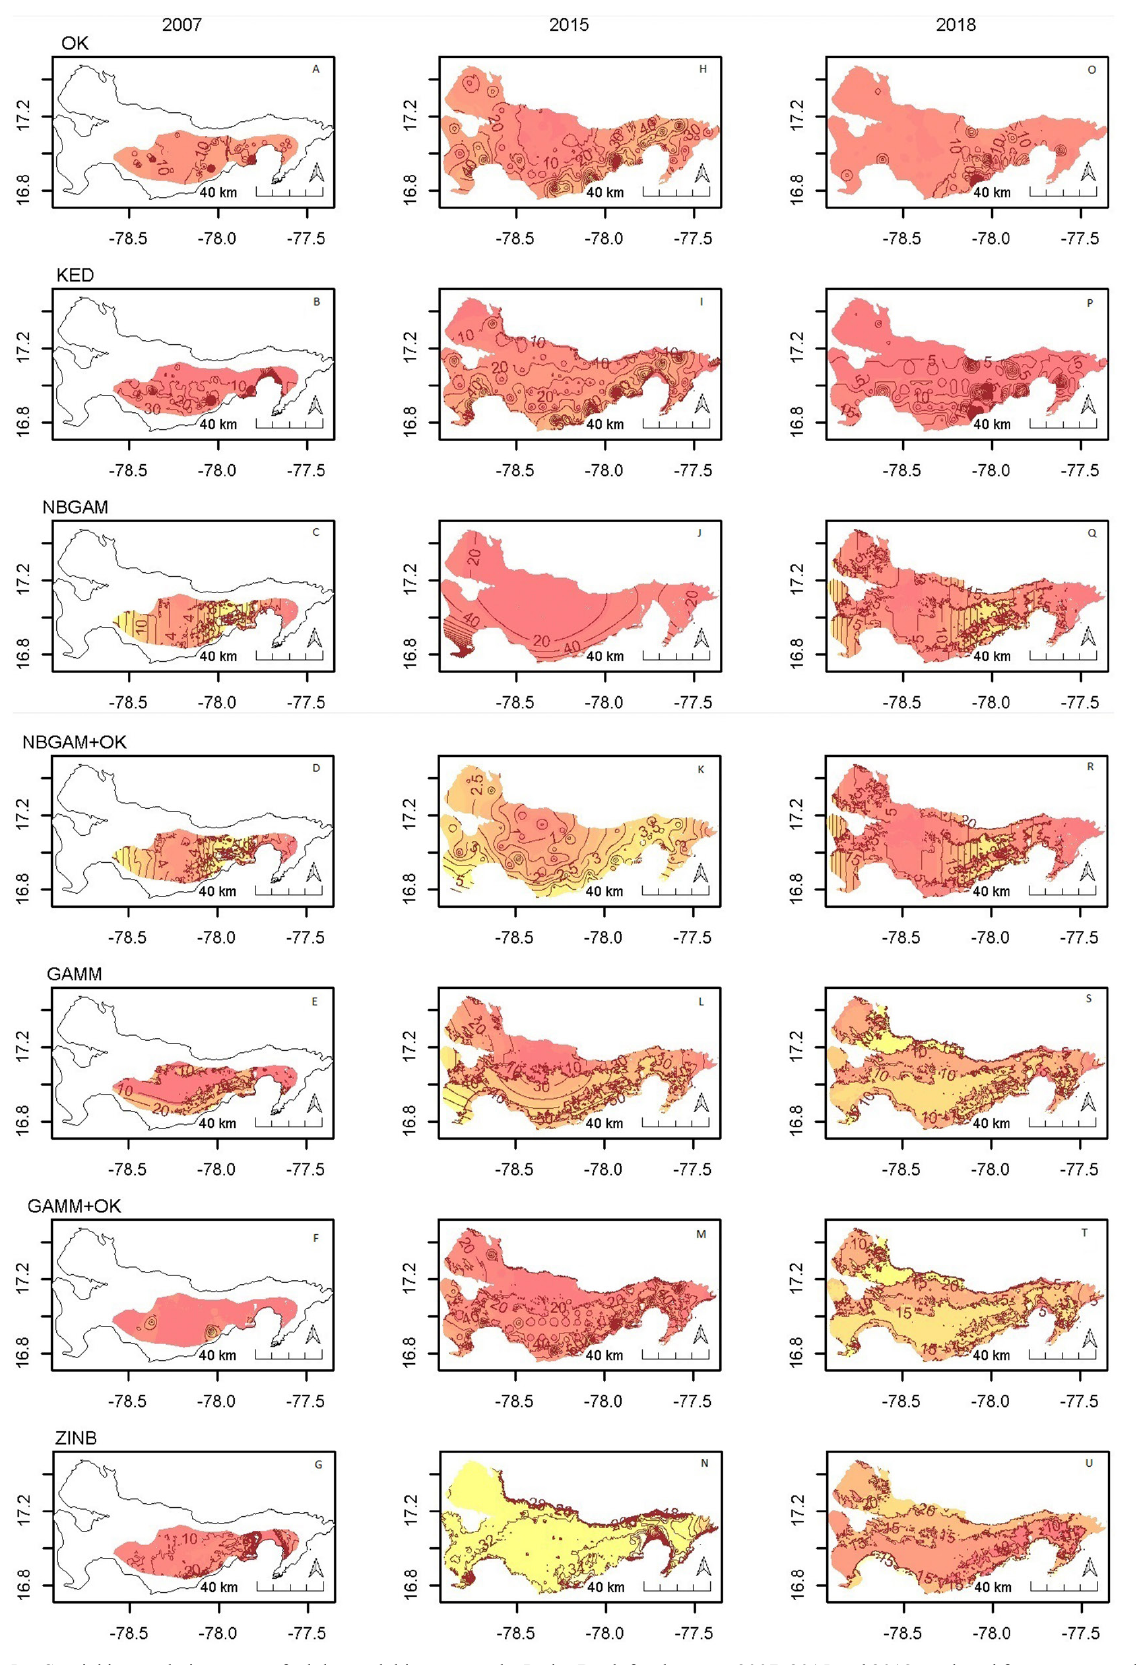
Fig. 5. – Spatial interpolation maps of adult conch biomass on the Pedro Bank for the years 2007, 2015 and 2018 produced from seven models: OK, KED, NBGAM, NBGAM+OK, GAMM, GAMM+OK and